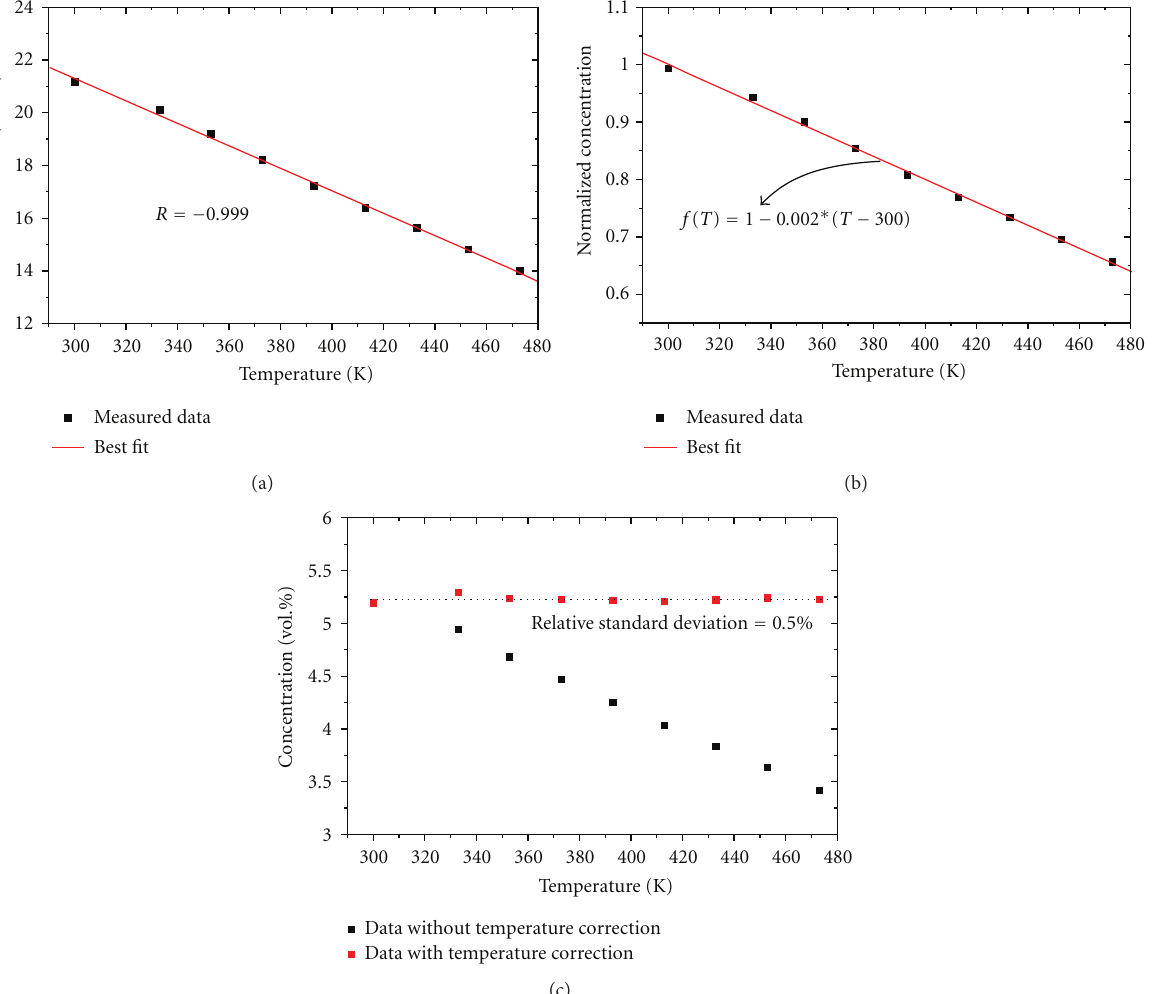
F 5: (Color online) concentration measurement evaluated by scheme B. (a) Concentrations by using atmospheric oxygen as the sample gas at � different temperatures between 300 and 473K; (b) normalized measurement results shown in (a) with the linear �t giving the effective temperature-correction coefficient expression; (c) evaluated concentrations before and aer temperature correction by using a standard gas mixture containing 5.1 oxygen as the sample %